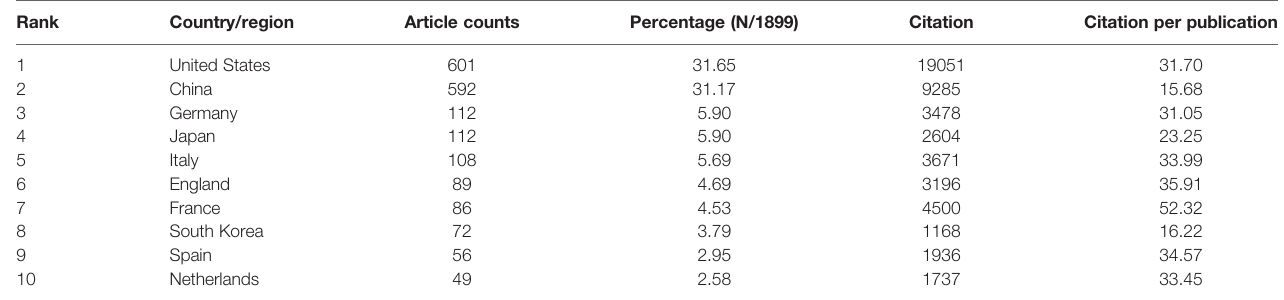
TABLE 1 | The top 10 productive countries/regions related to colorectal cancer immunotherapy. Rank Country/region Article counts Percentage